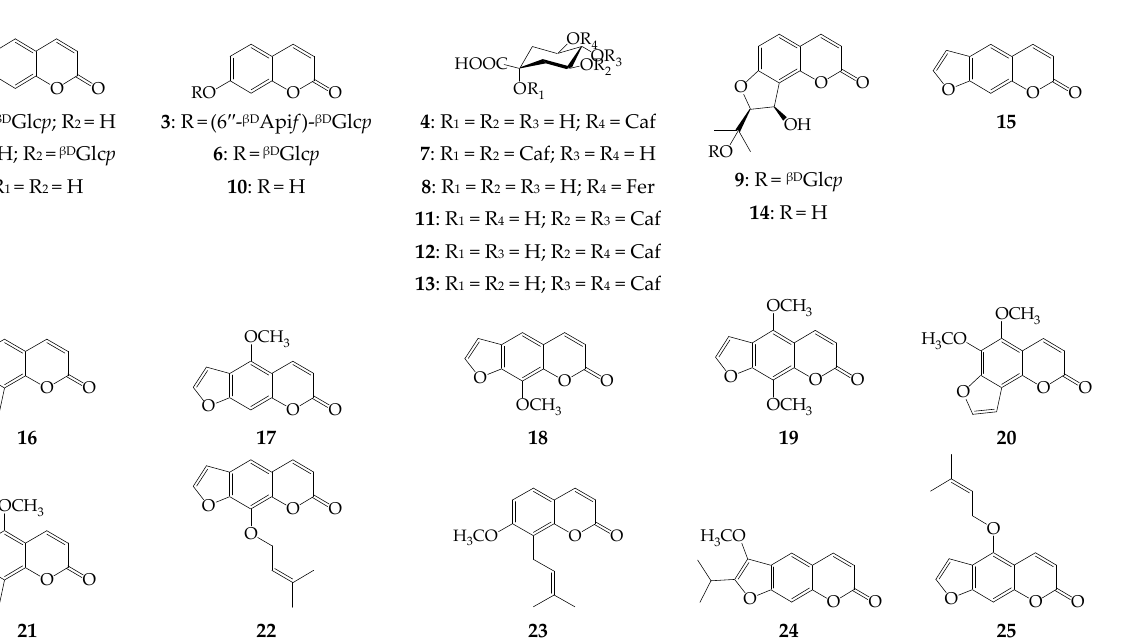
Figure 2. Compounds 1 – 25 found in fresh lovage roots. β D Api f – β -D-apiofuranose; Caf–caffeoyl; Fer–feruloyl; β D Glc p – β -D-glucopyranose.